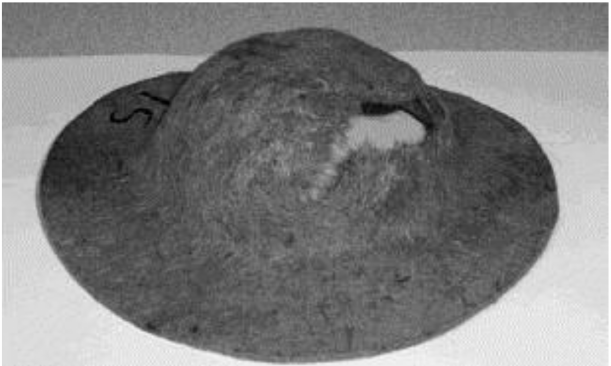
Figure 17. Kenaf–PP/MAPP composite hybrid composites tested for hardness properties [304]. Extracted with